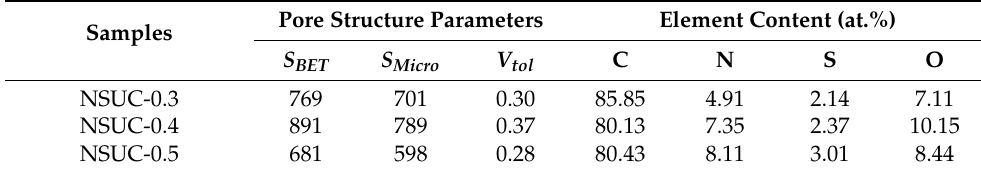
Figure 2. ( a ) N 2 physisorption isotherms and ( b ) pore size distributions of NSUC ‐ x.